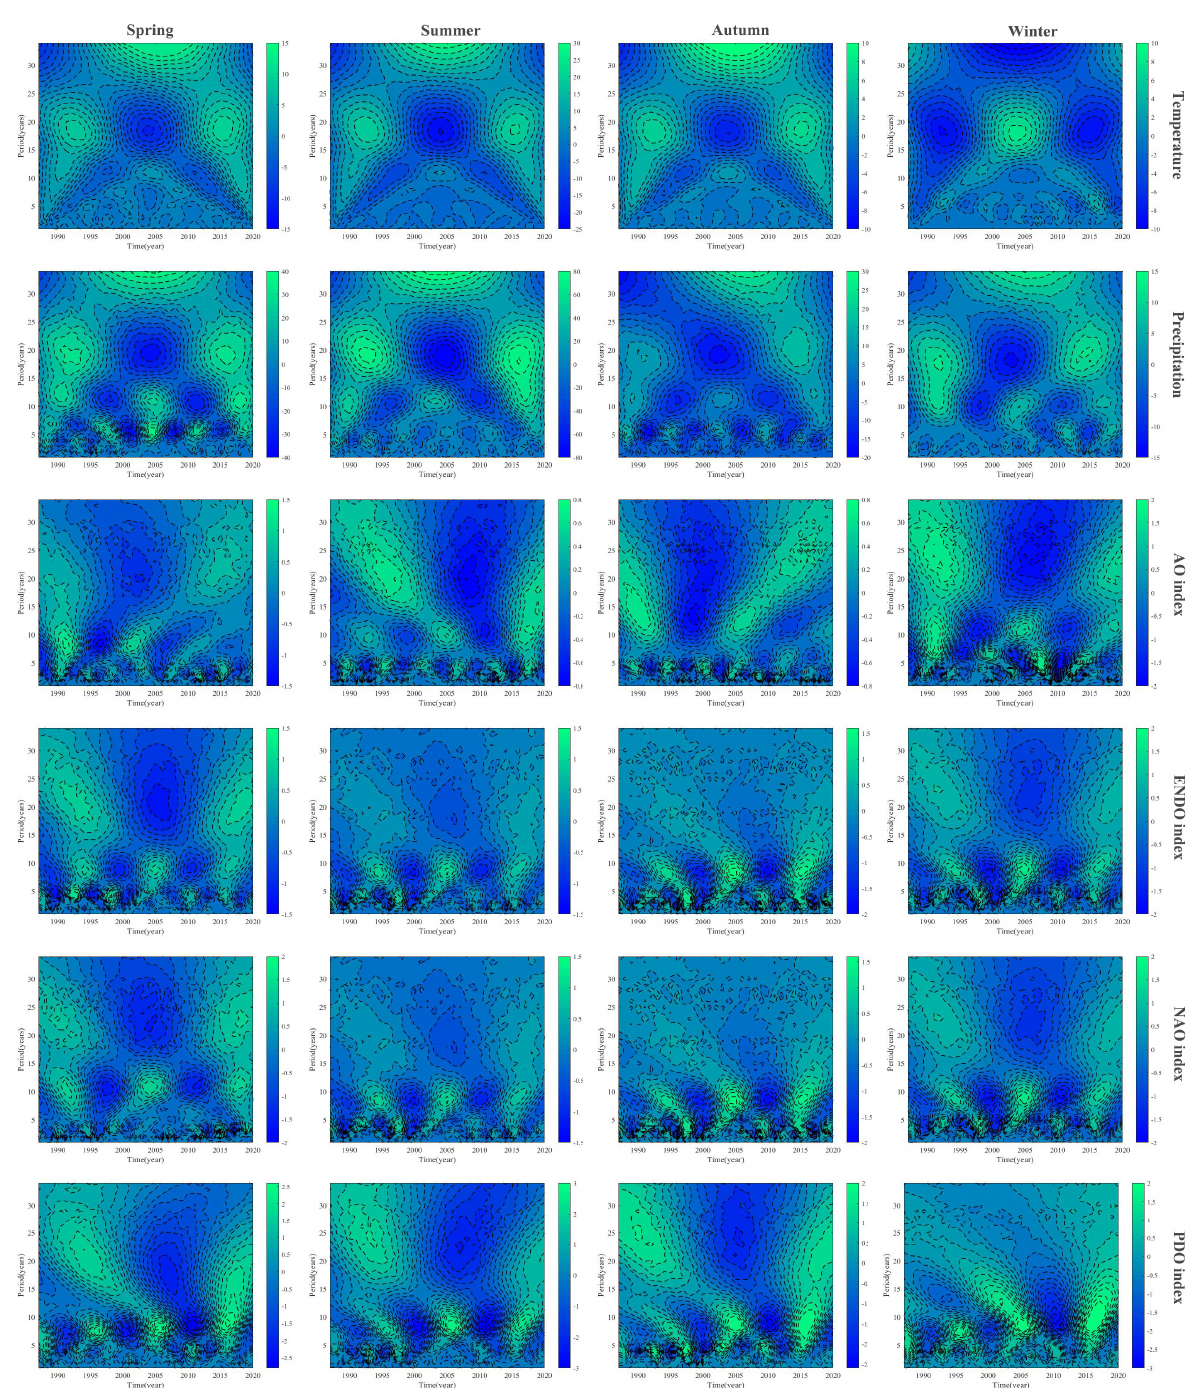
Figure 3. The wavelet transforms of climate change and atmospheric conditions in the Tarim Basin from 1987 to 2020 (Different factors of climate change and atmospheric circulation are listed on the horizontal and at different seasonal scales on the vertical).